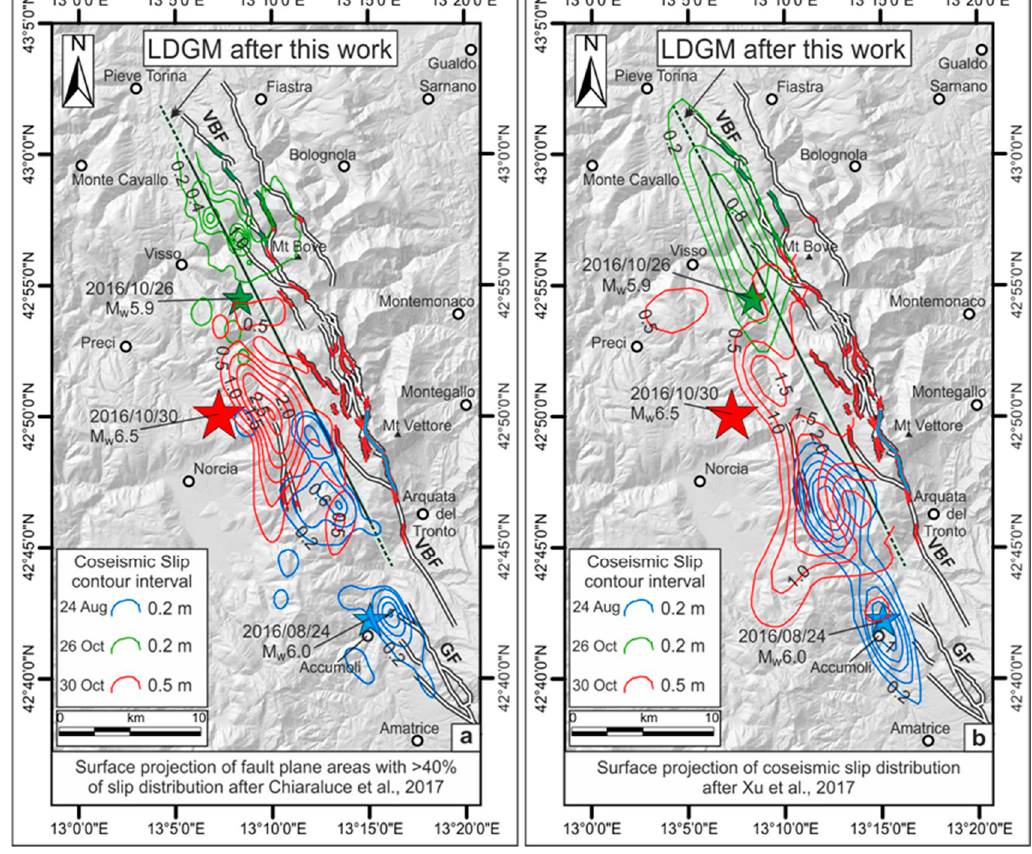
Figure 8. Maximum extent of LDG ( LDGM) compared with surface projections of coseismic slip distribution of major events occurring on the VBF fault plane after [3] ( a ) and [31] ( b ). Blue contour lines locate the slip estimates for the 24 August 2016 event, green contour lines locate slip estimates for the 26 October 2016 event, red contour lines locate slip estimates for the 30 October 2016 event. Black rimmed white lines locate VBF fault segments. Colored strips along VBF show the coseismic surface ruptures according to Figure 1. Stars: epicenters of the mainshock.